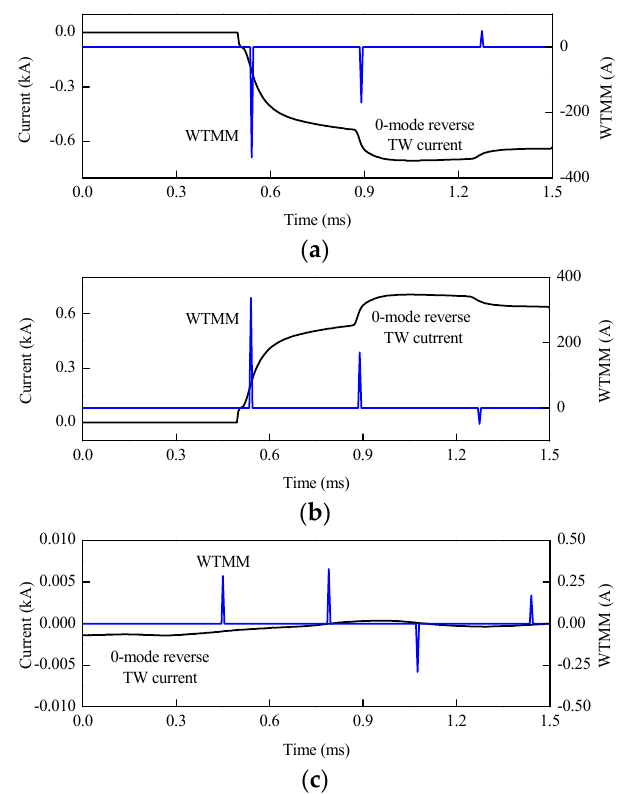
Figure 17. WTMMs of 0-mode reverse TW current for different fault types: ( a ) WTMM for positive pole-to-ground fault; ( b ) WTMM for negative pole-to-ground fault; ( c ) WTMM for pole-to-pole fault.